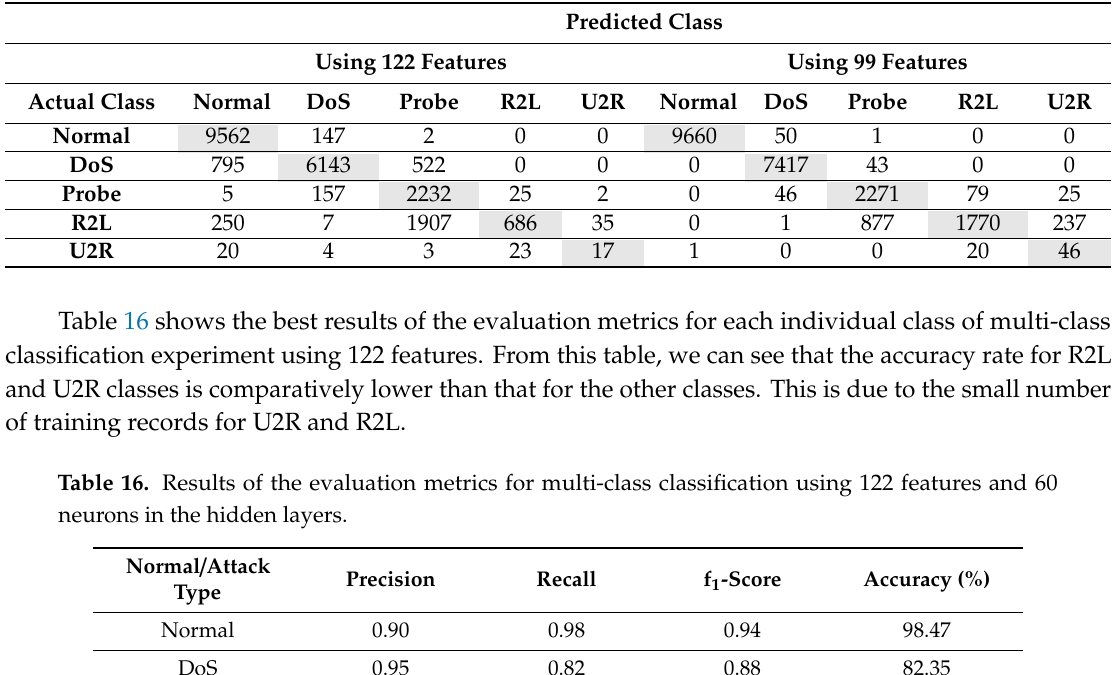
Table 15. The confusion matrices of multi-class classification on KDDTest + (122 features vs. 99 features).